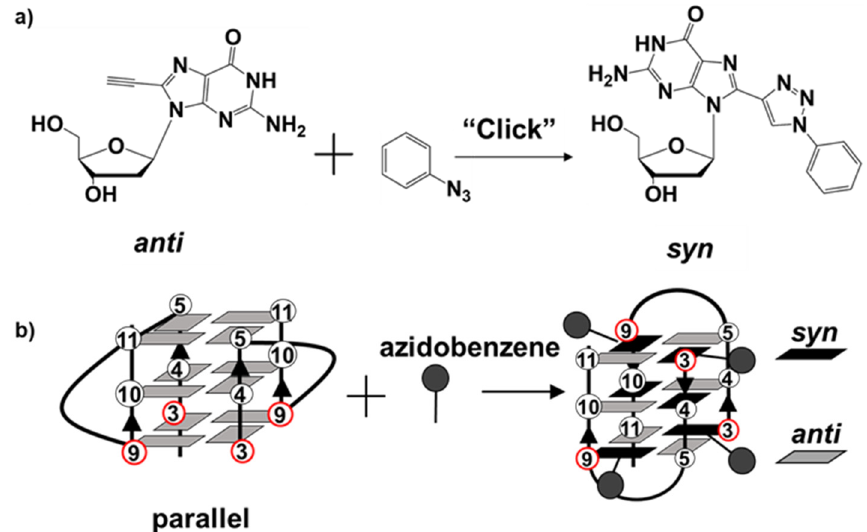
Figure 1. ( a ) Click reaction controls the glycosidic conformation of modified guanine nucleoside. ( b ) G-quadruplex topology changed by manipulating the glycosidic conformation of modified guanine nucleoside through click reaction.